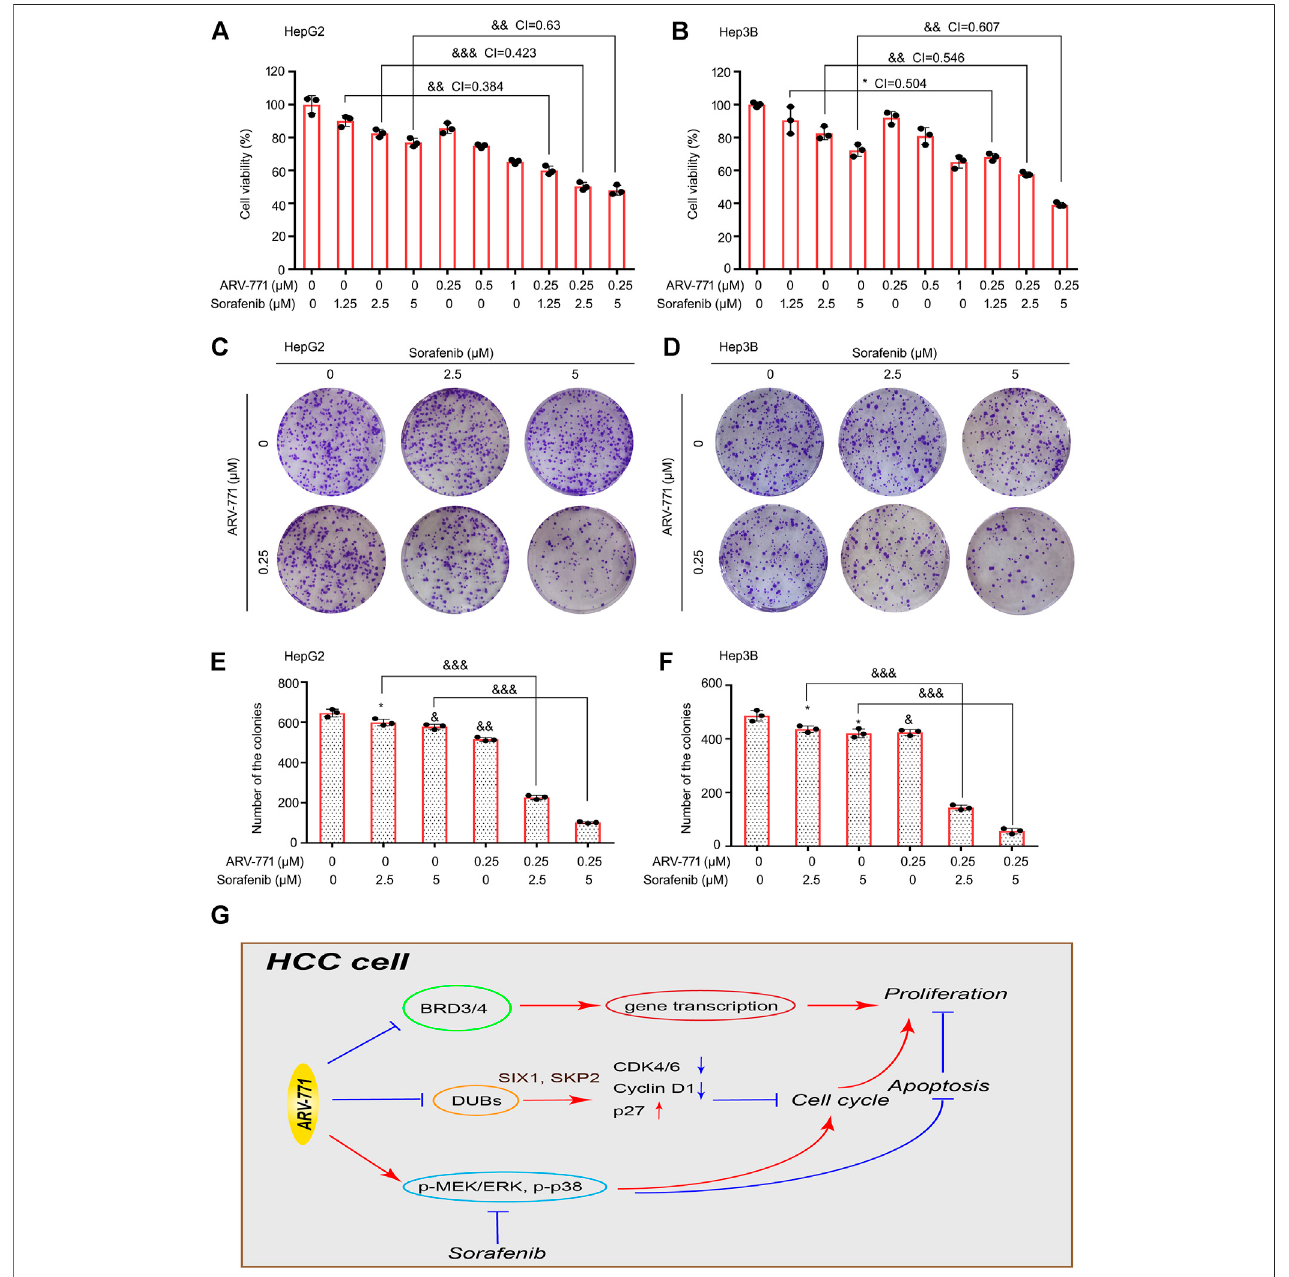
FIGURE7| ARV-771elevatestheeffectivenessofsorafenibtoHCCcells. (A) – (B) CellviabilityassayswereconductedinHepG2andHep3BcellsexposedtoARV- 771 with or without sorafenib for 24 h. CI, combination index (CI value less than 1 means the synergistic effect between two drugs). * p < 0.05, && p < 0.001, &&& p